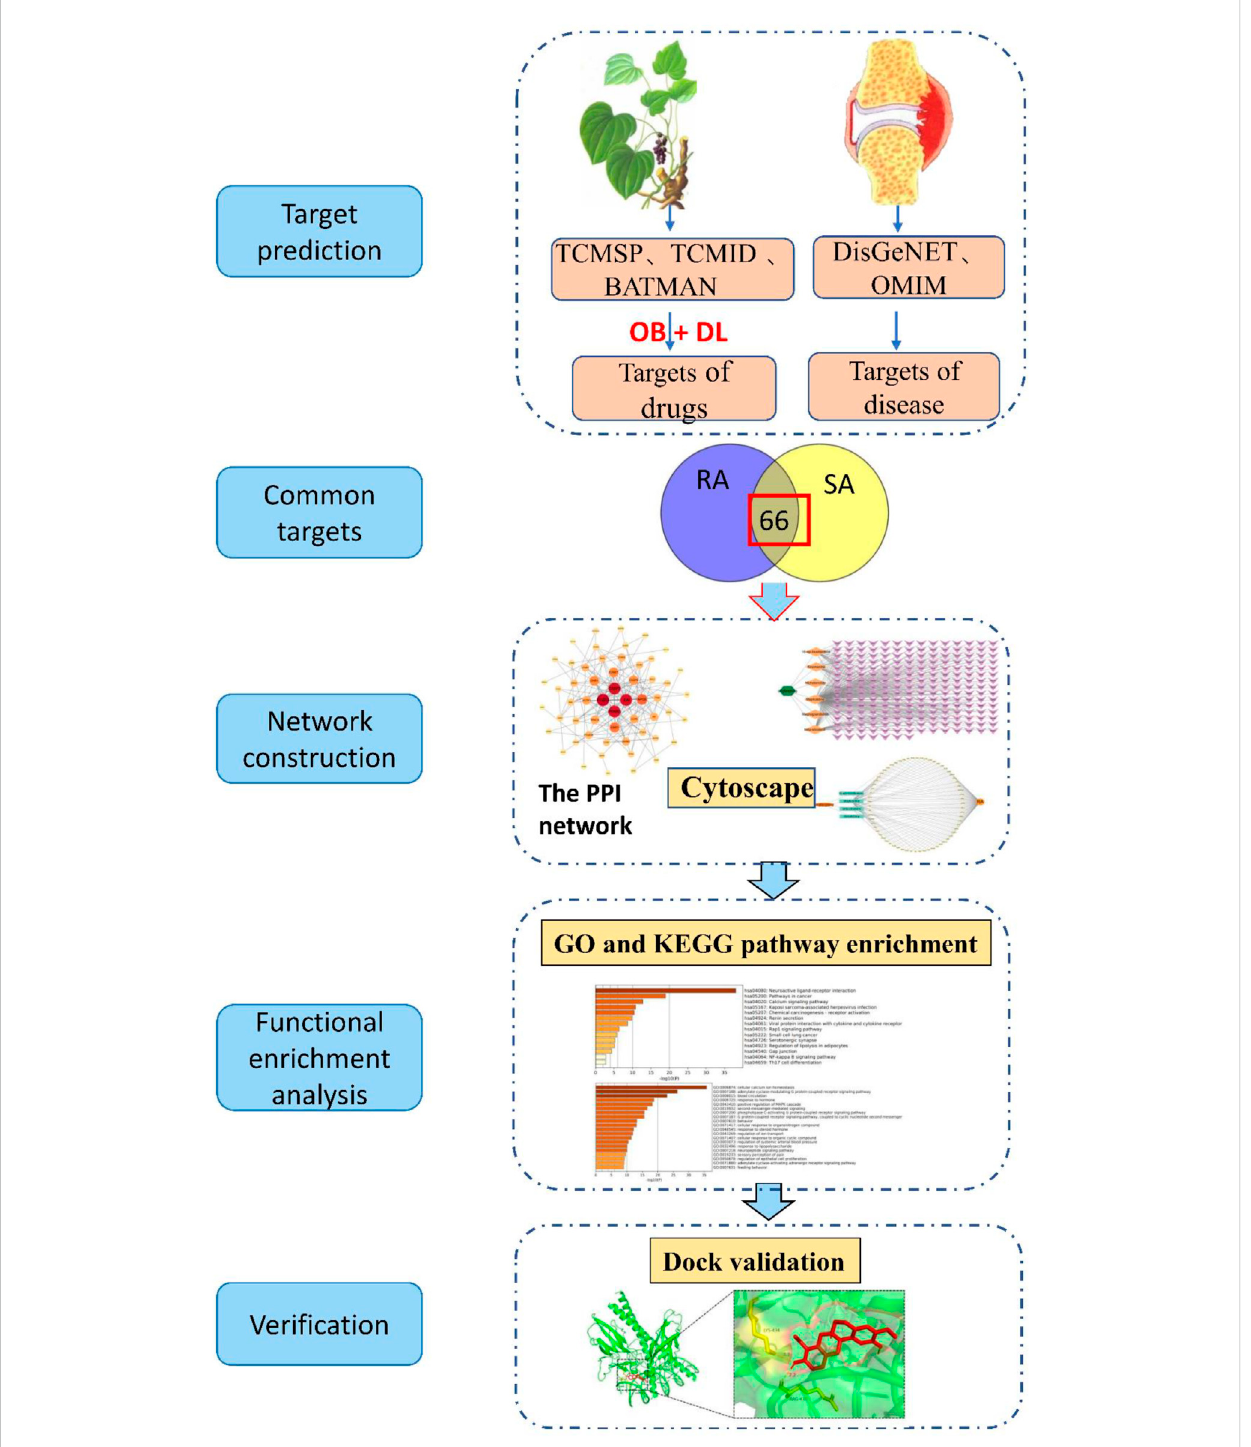
FIGURE 1 The work fl ow of the analysis for this study. TCMSP (Traditional Chinese Medicine Systems Pharmacology Database and Analysis Platform), TCMID (Traditional Chinese Medicines Integrated Database), BATAMN (Bioinformatics Analysis Tool for Molecular mechANism of Traditional Chinese Medicine), DisGeNET (a database of gene-disease associations), OMIM (Online Mendelian Inheritance in Man), OB (oral bioavailability), DL (drug-likeness), RA (Rheumatoid arthritis), SA (Sinomenium acutum), PPI (protein-protein interaction network), GO (Gene Ontology), KEGG (Kyoto Encyclopedia of Genes and